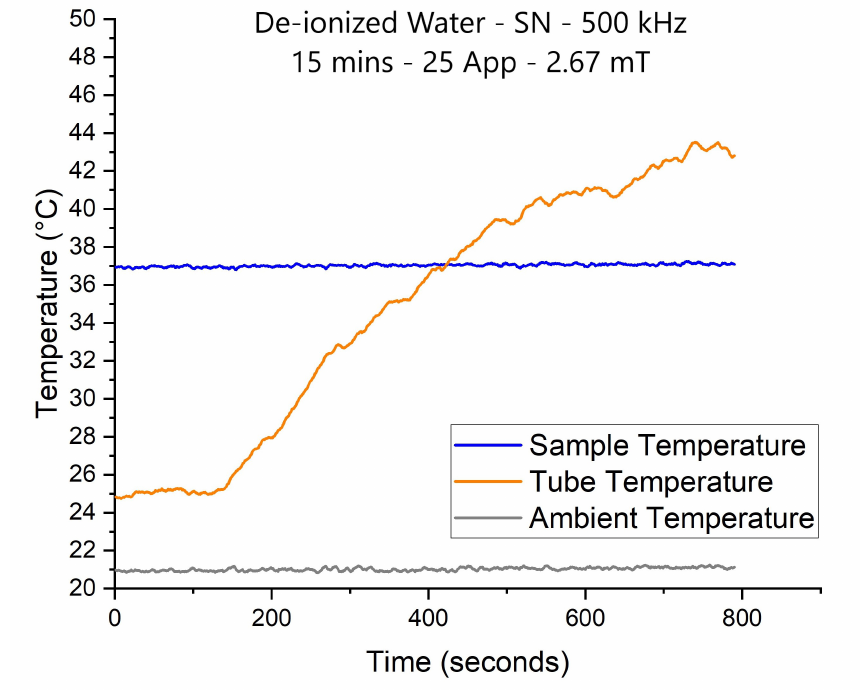
Figure 4. Sample temperature isolation test using de-ionized water. The blue, orange and gray curves represent the sample, Pasteur pipette and ambi- ent temperature. The results show that the Pasteur sensor is highly affected by the coil temperature outside the calorimeter, yet the sample’s temperature is fixed at 37 ◦ C. The experiment in Figure 4 was stopped at 800 s because the coil’s temperature reached 150 ◦ C on the thermal camera. This proves that the sample is totally isolated from external thermal stressors; hence, any temperature variation detected inside the sample is generated by the rotating